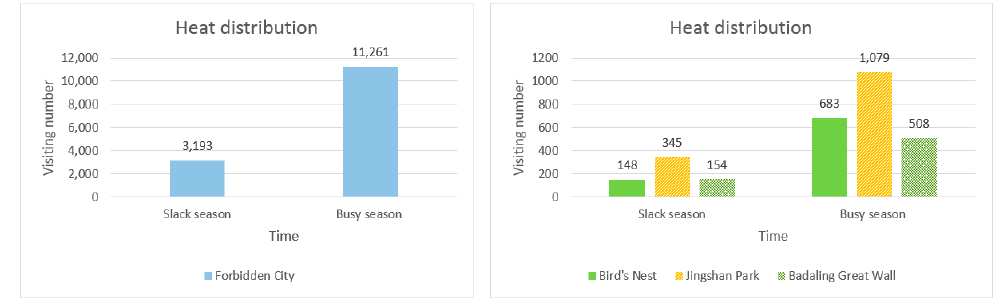
Figure 16. Heat distribution map divided by slack/busy seasons.